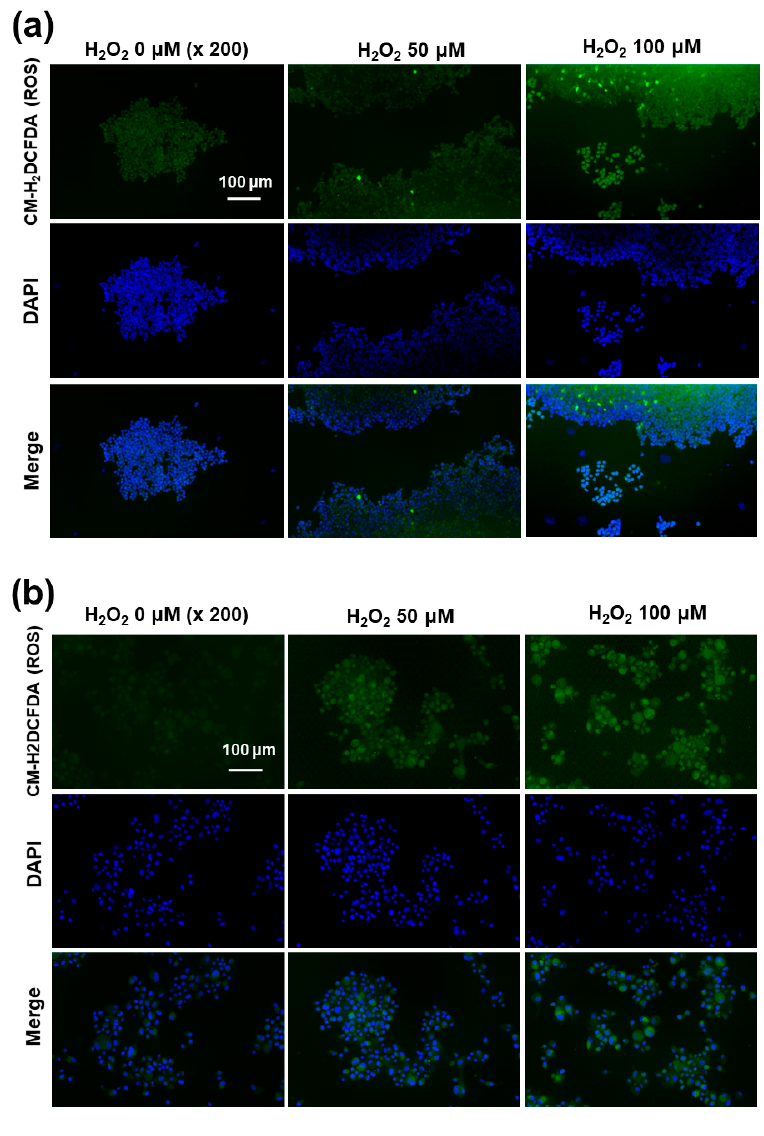
Figure 8. Fluorescence observation of SH-SY5Y cells ( a ) and U87MG cells ( b ). The effect of H 2 O 2 on the intracellular ROS intensity. U87MG cells (1 × 10 5 ) or SH-SY5Y cells (1 × 10 5 ) were treated with 100 µM H 2 O 2 for 6 h. After that, cells were stained with CM-H 2 DCFDA.